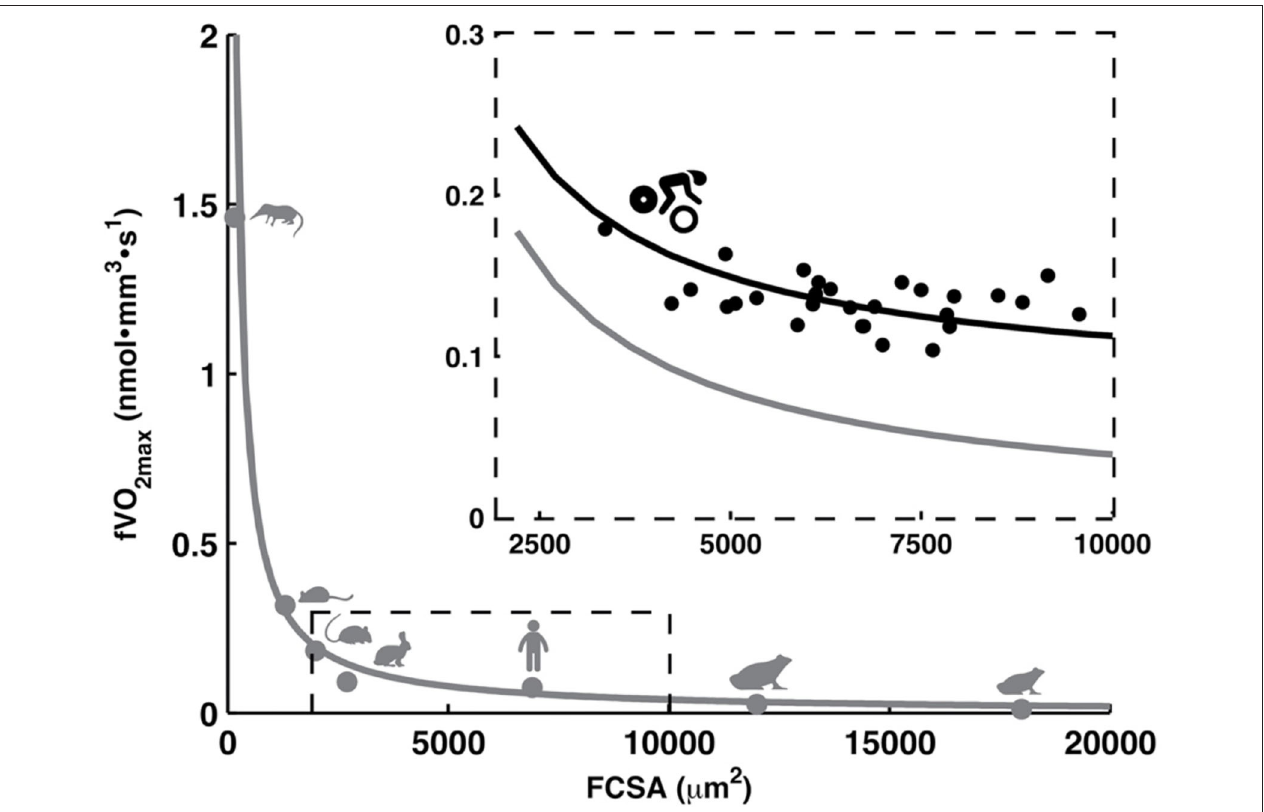
FIGURE 1 | Muscle fiber size (FCSA) and muscle fiber oxidative capacity ( ˙ VO 2max ) are inversely related across animal species [ r = − 0.98, P < 0.001 (van der Laarse et al., 1998; van Wessel et al., 2010)] and in competitive cyclists [ r = − 0.50, P < 0.05 (van der Zwaard et al., 2018b)]. From left to right, animals include the